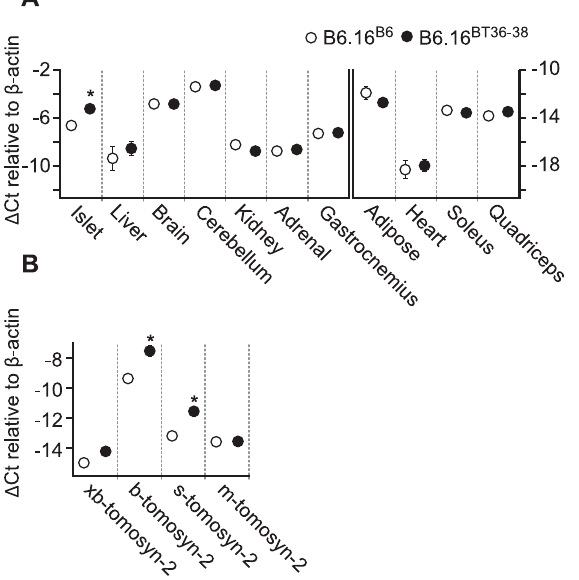
Figure 7. Increased expression of tomosyn-2 gene in islets of the B6.16 BT36–38 mice. Total mRNA was extracted from islets, liver, brain, cerebellum, kidney, gastrocnemius, adipose, heart, soleus, and quadriceps of the B6.16 BT36–38 and B6.16 B6 mice. Relative abundance was determined by real-time PCR of the cDNA. The D Ct was calculated by subtracting the raw Ct of tomosyn-2 gene from the raw Ct of the b - actin gene. A) The mRNA abundance of the tomosyn-2 gene in different tissues. Left: tissues that have a relatively higher level of tomosyn-2 expression. Right: tissues with a relatively low level of tomosyn-2 expression. B) Relative expression of the tomosyn-2 isoforms in the islets. Values are means 6 S.E. of N $ 4. *( p # 0.05 for the expression of tomosyn-2 gene in tissues of the B6.16 BT36–38 mice vs. control B6.16